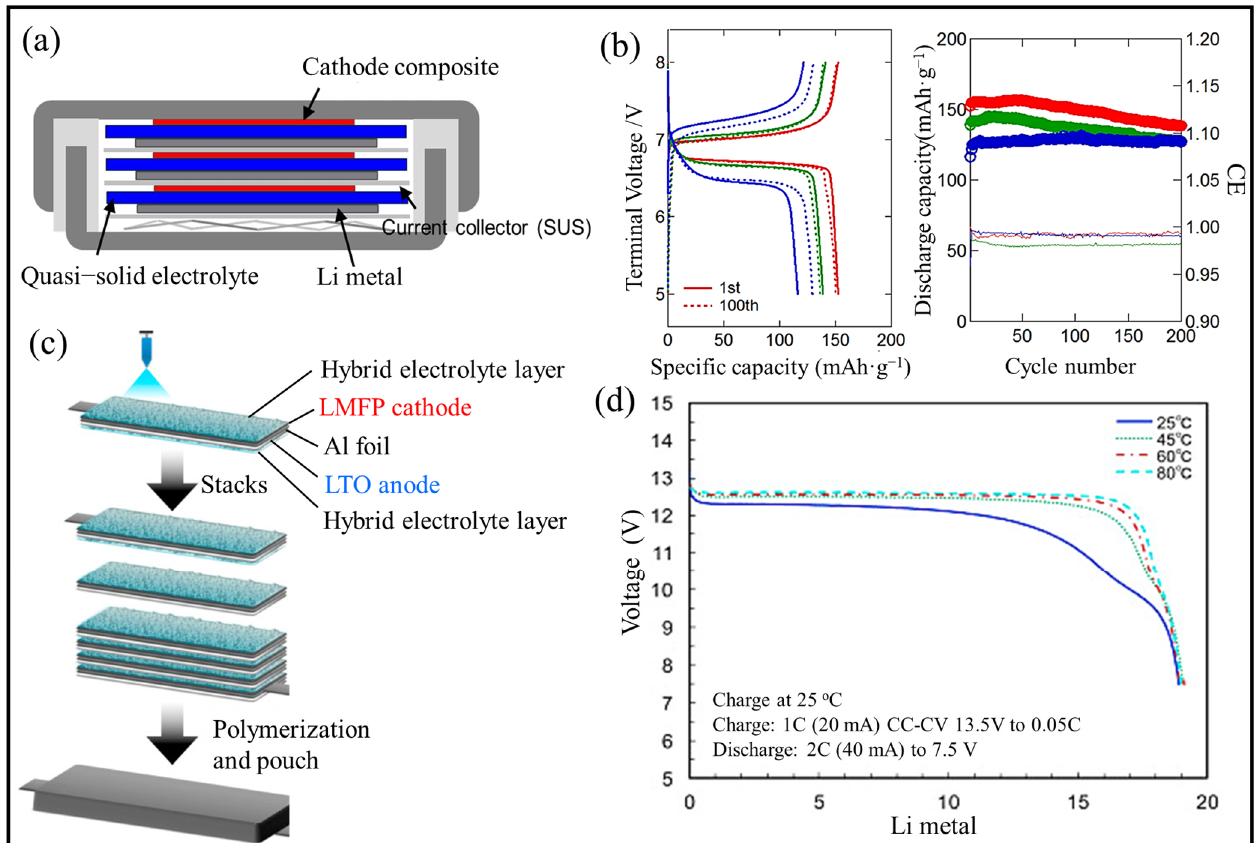
Figure 9. ( a ) Structure of a triple-layered bipolar stacked all-solid-state LIBs; ( b ) 1st and 100th charge-discharge pro fi les (left) and cycling properties of double-layered all-solid-state LIBs at 35 °C at 0.1 C (red), 0.2 C (green) and 0.5 C (blue) rates (right) [300]; ( c ) Schematic process for the preparation of bipolar ba tt eries ( d ) Discharge curves of a 12 V bipolar ba tt eries at high temperatures [301].